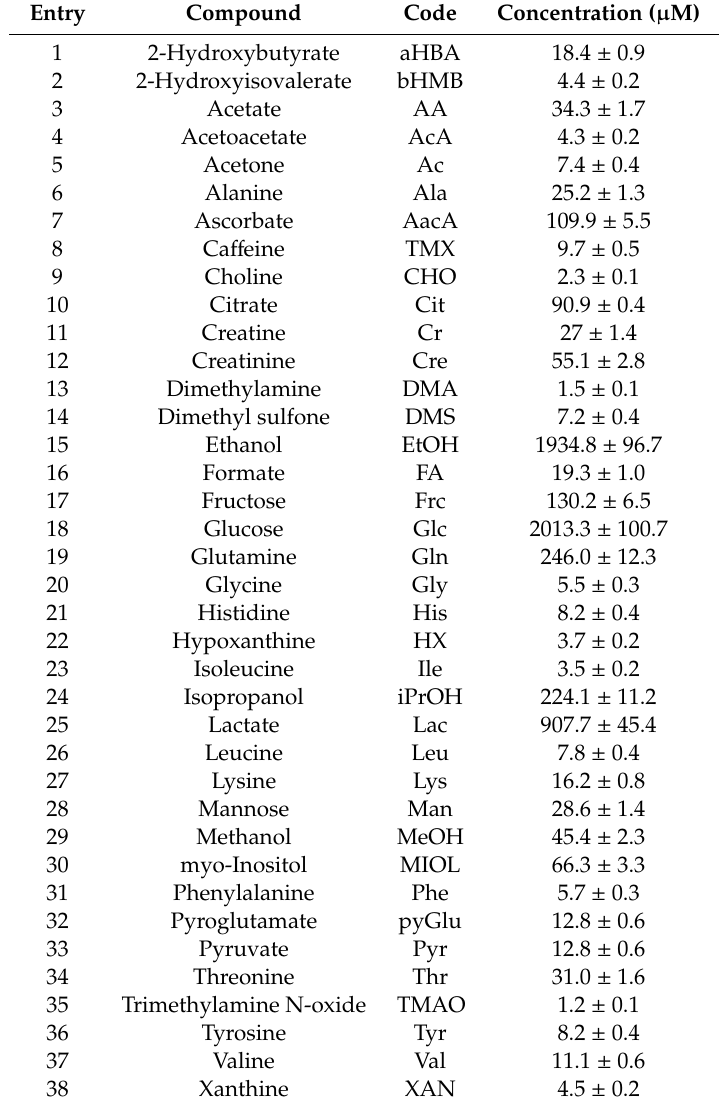
Table 2. List of metabolites and concentrations ( µ M) determined in one of the pooled CSF samples (i.e., LT = low temperature pooled sample, see